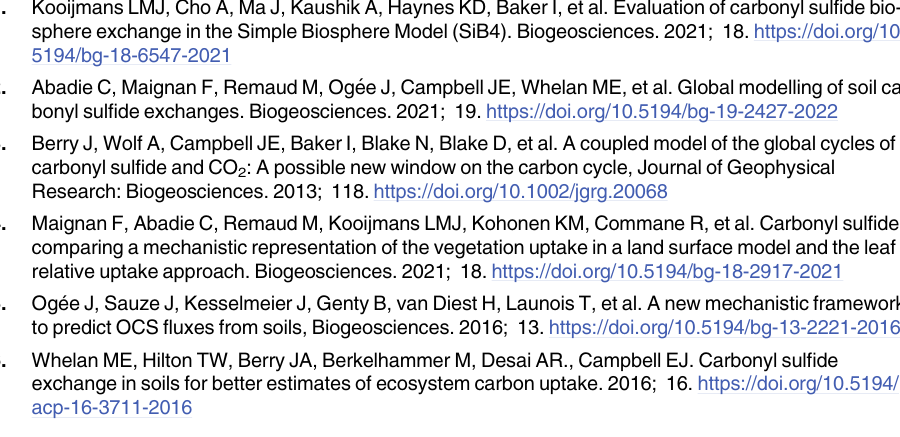
Lower panel: March 1 st to July 31 st , 2021. Refer only to the purple curves.